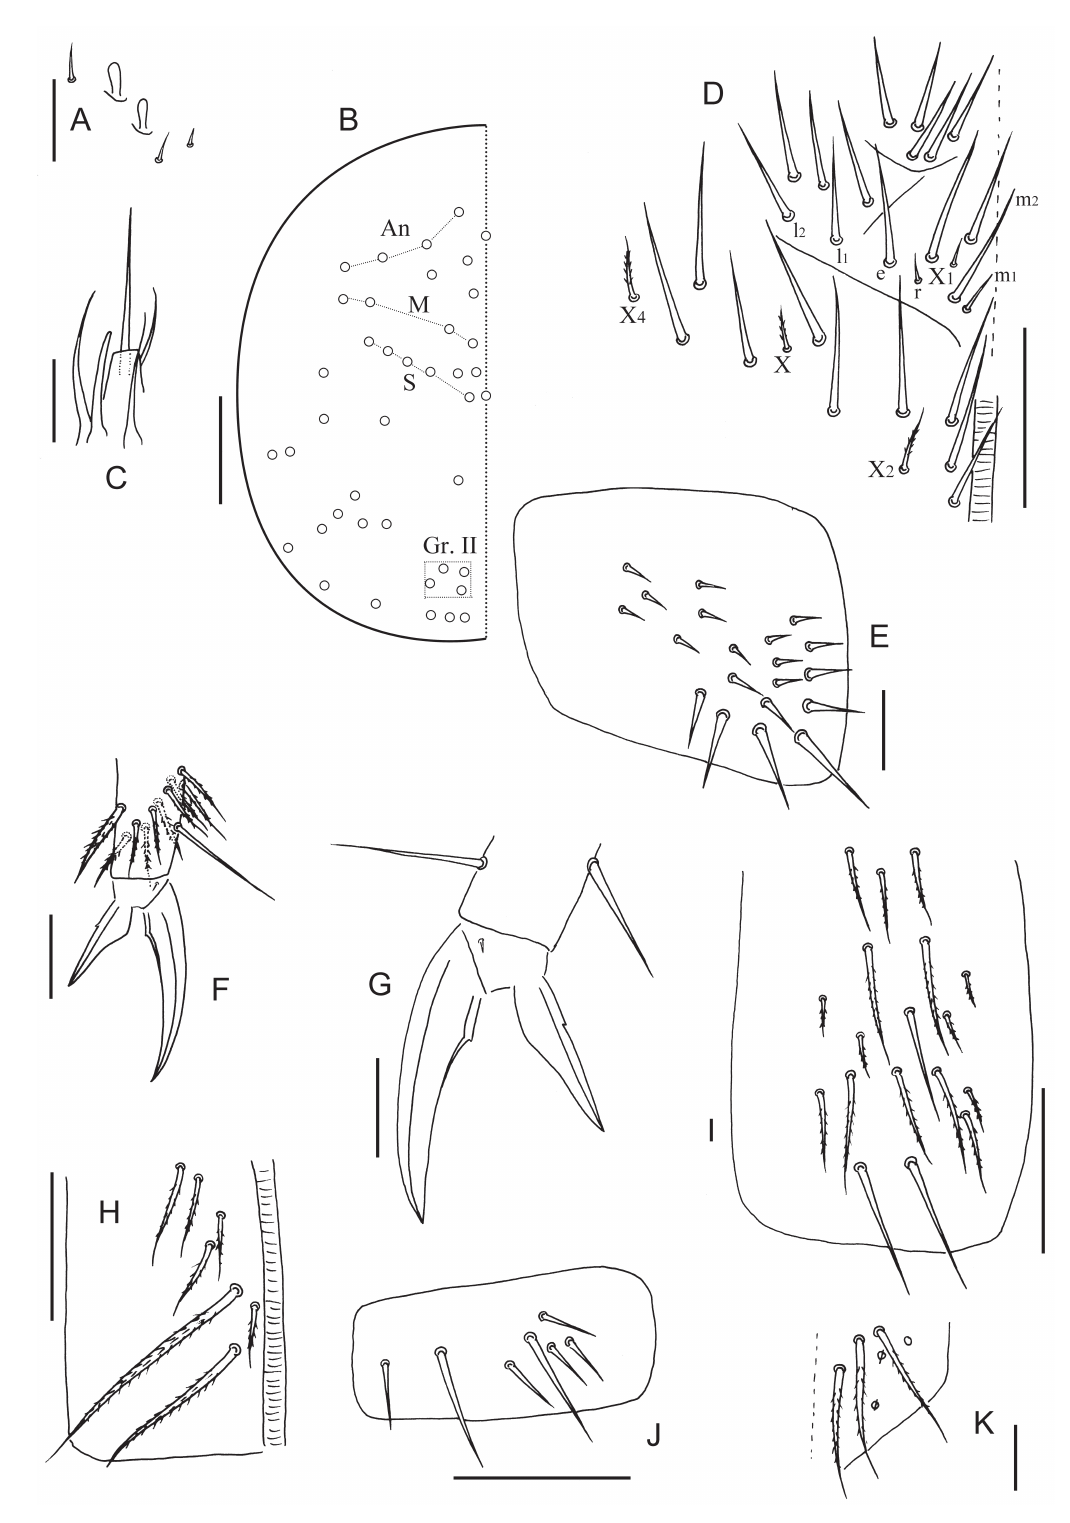
Fig. 2. Coecobrya gejianbangi sp. nov. A . Ant. III organ. B . Dorsal cephalic chaetotaxy. C . Lateral process of labial palp. D . Chaetae on the ventral side of head. E . Trochanteral organ, ventral view. F . Fore claw. G . Hind claw. H – J . Ventral tube. H . Anterior face. I . Posterior face. J . Lateral flap. K . Manubrial plaque. Scale bars: A, C, E‒G, K = 40 μm; B, D, H‒J = 100